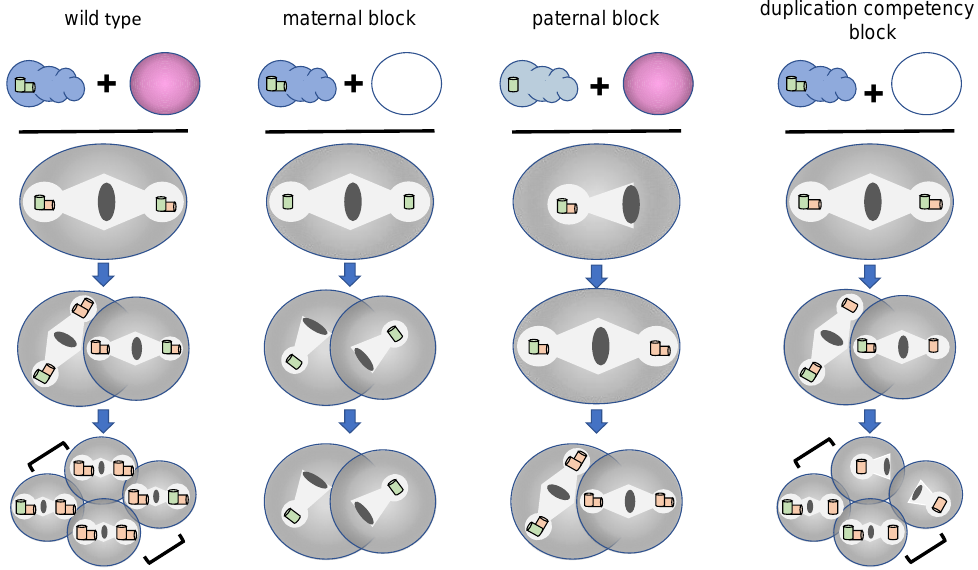
Figure 4. Patterns of spindle assembly in centriole duplication mutants. Spindle assembly phenotypes caused by different types of centriole assembly defects are depicted. The cellular composition of sperm (blue) and eggs (pink) that give rise to a particular spindle assembly pattern are shown at the top. Sperm centrioles are shown in green while centrioles generated in the embryo are shown in orange. Gametes drawn in lighter colors indicate the absence of a centriole assembly factor in either the maternal or paternal germ line. Brackets indicate sister cells in four-cell embryos. Wild-type embryos inherit a centriole pair from sperm that is duplicated faithfully during each cell cycle, giving rise to only bipolar spindles with centriole pairs at the poles. In a maternal block to duplication the sperm centriole pair is not duplicated in the embryo yielding a bipolar spindle with single centriole at each pole during the first cell cycle and monopolar spindles thereafter (bi/mono/mono pattern). In a paternal block, sperm donate a single centriole that is duplicated in the embryo yielding a monopolar spindle with a centriole pair at its pole during the first cell cycle, followed by bipolar spindles during subsequent cell cycles (mono/bi/bi pattern). In embryos exhibiting a maternal block to centriole maturation, the sperm centrioles duplicate normally but the daughters are unable to produce their own offspring. This results in the appearance of monopolar spindles during the third cell cycle (bi/bi/mixed mono pattern).